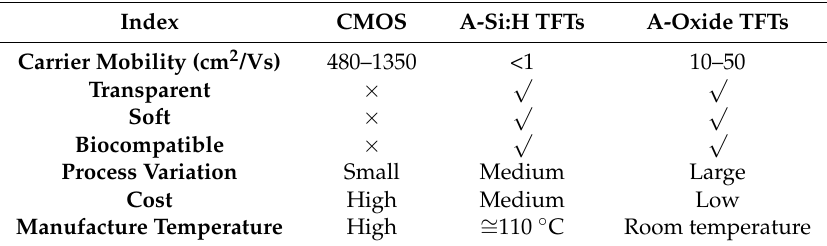
Table 1. Comparisons among different devices